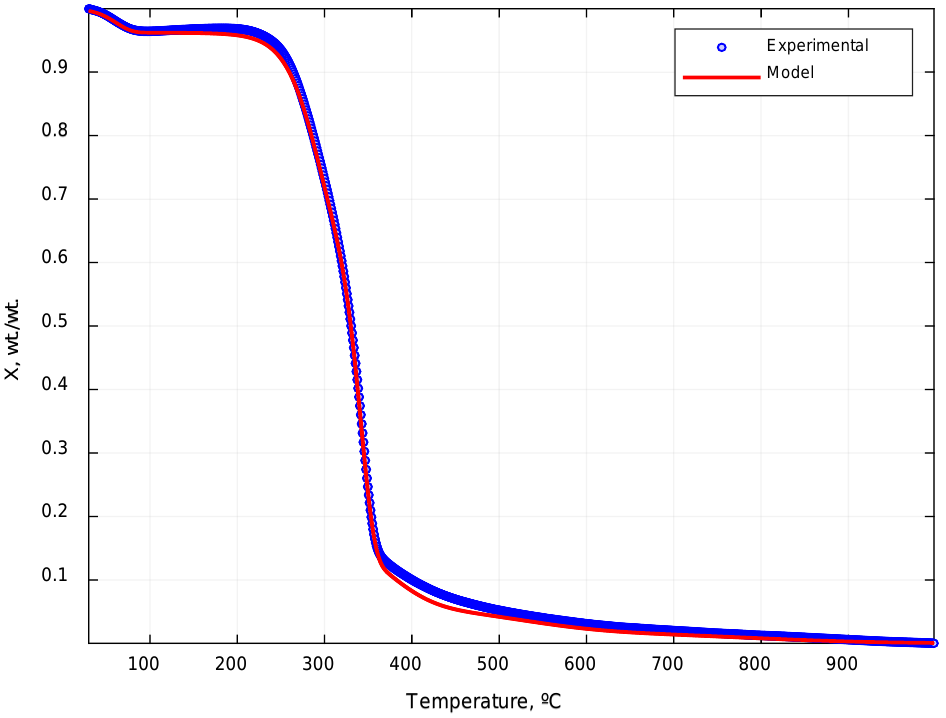
Figure 10. Model fitted to the experimental poplar TG curve.